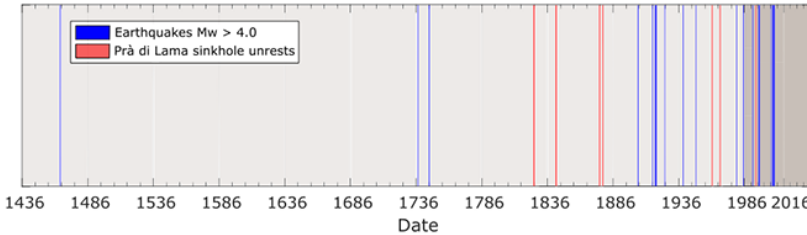
Figure 8. Comparison between the earthquakes (blue lines) in the Garfagnana area (INGV Catalogo Paramentrico dei Terremoti Italiani CPTI15, Rovida et al., 2016) and events of unrest at the Prà di Lama sinkhole (red lines). Light grey shading marks the time period covered by CPT15, while dark grey shading is the period covered by